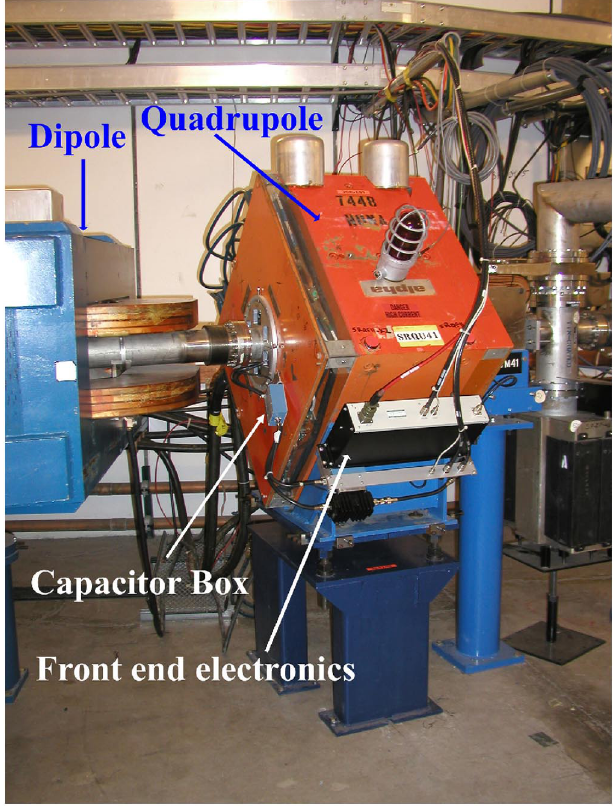
FIG. 5. (Color) Diagnostic installed in quadrupole magnet (SRQU41) in the ring tunnel. The front end electronics module is attached to the side of the quadrupole magnet. The end field region of the adjacent dipole is also